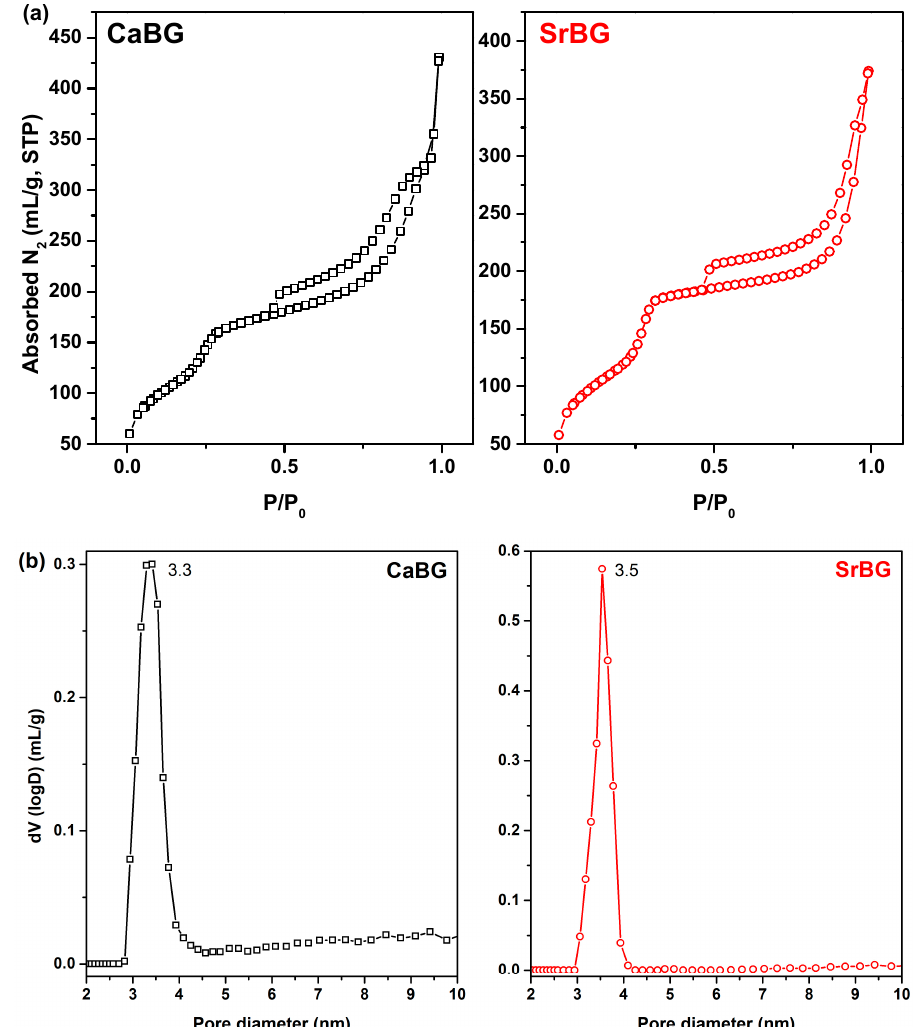
Figure 4. ( a ) N 2 adsorption-desorption isotherms and ( b ) respective pore size distributions of CaBG and SrBG BGs.